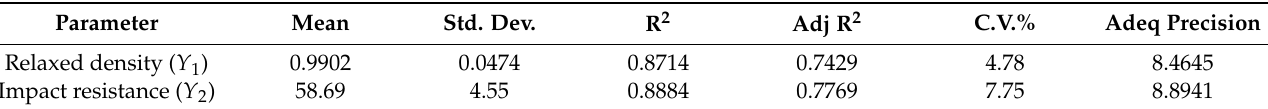
Table 7. RSM model fit summary output for relaxed density and impact